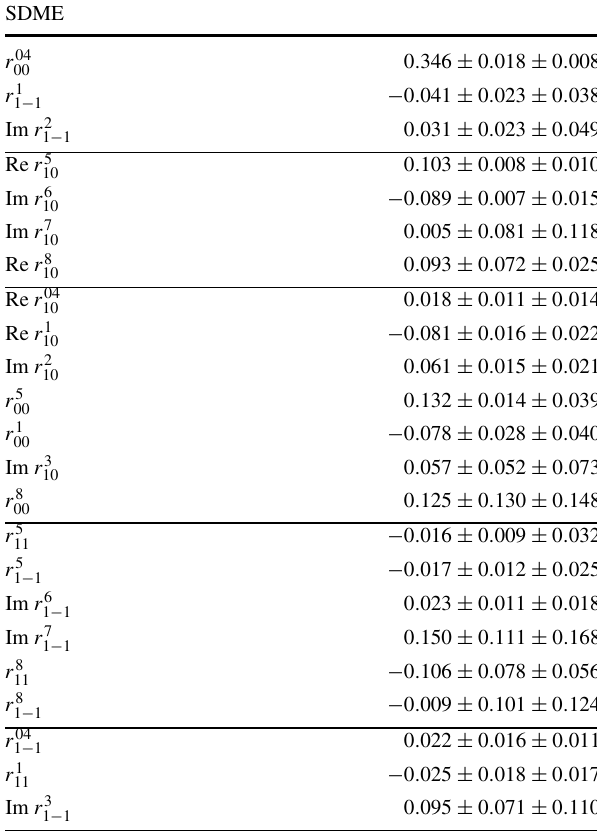
Table 1 The 23 unpolarised and polarised SDMEs for the total COM- PASS kinematic region, shown in the same order as in Fig. 5 for classes A to E. The first uncertainties are statistical, the second